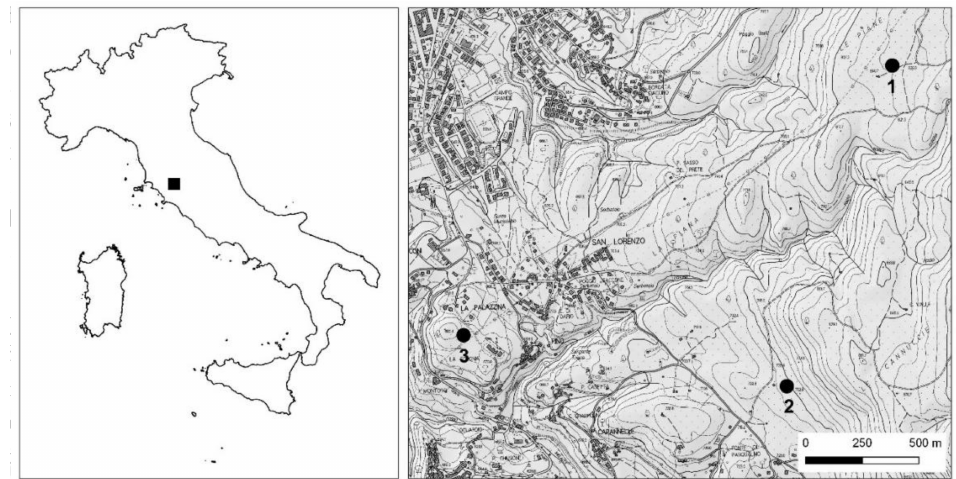
Figure 1. Location of the three study areas.